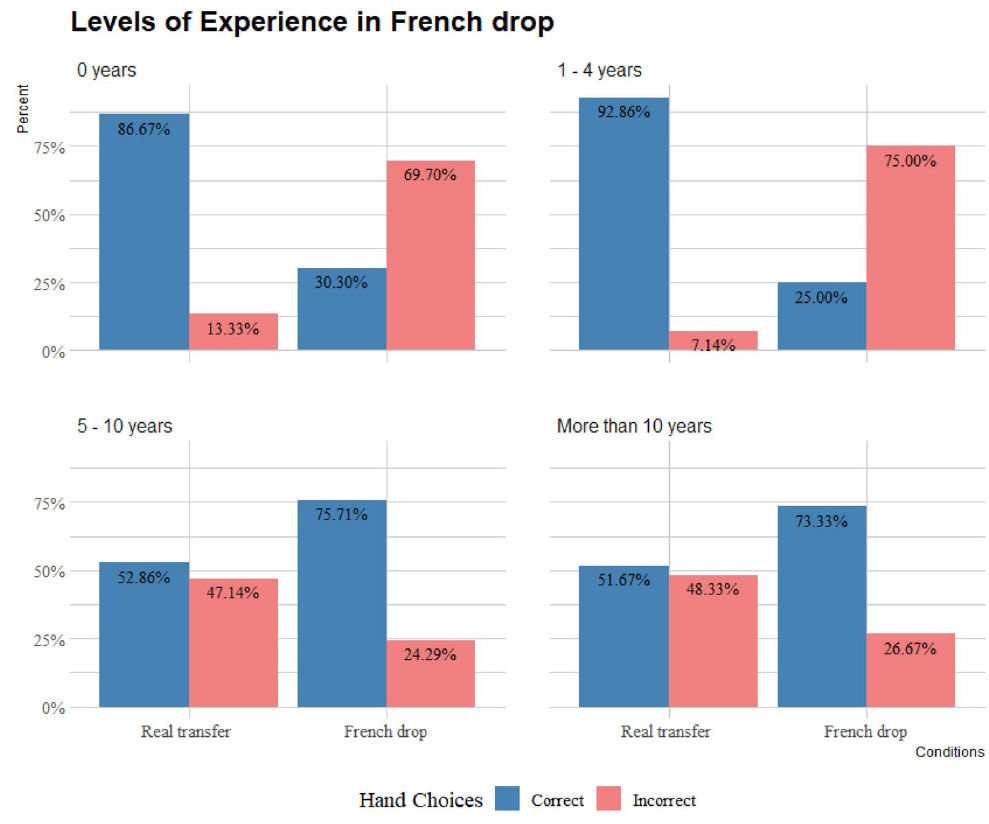
Figure 5. Choices in French drop, and real transfer counterpart separated by levels of experience practicing